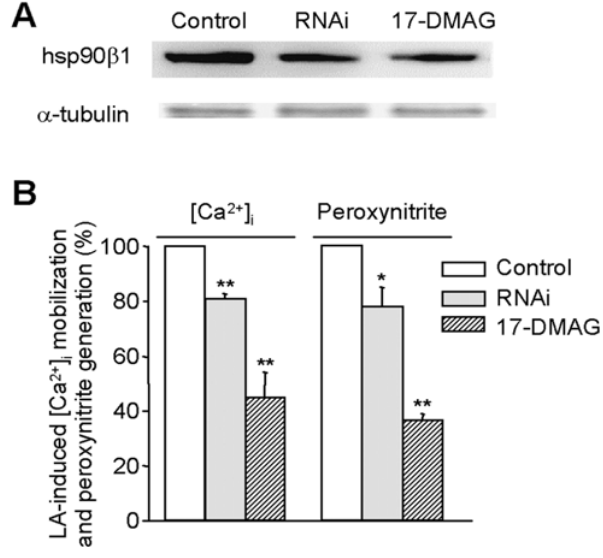
Figure 5. The effect of hsp90 b 1 on LA-induced [Ca 2 + ] i mobilization and peroxynitrite generation. HM cells were treated with vehicle (control), hsp90 b 1 RNAi, or 17-DMAG for 48 h. (A): Cell lysates were prepared and the alterations of hsp90 b 1 expression were analyzed by western blot analysis using a -tubulin as loading control. (B): The alteration of LA-induced [Ca 2 + ] i mobilization and peroxynitrite generation in hsp90 b 1 RNAi- and 17-DMAG-treated HM cells relative to control. The values represent the mean 6 SEM. * P , 0.05, ** P , 0.01,